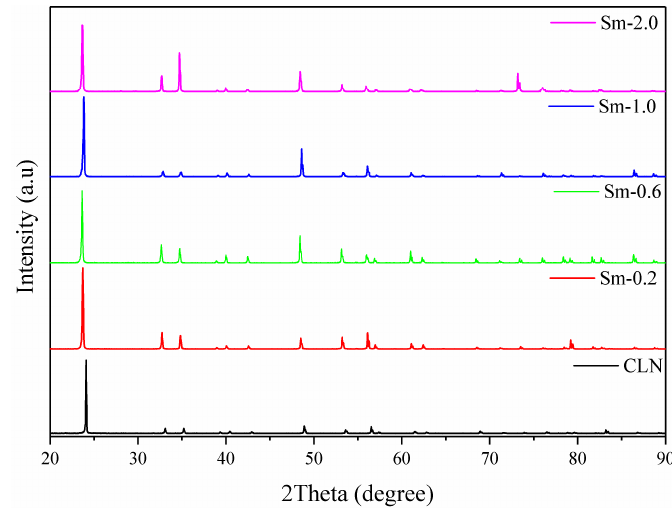
Figure 2. X-ray powder diffraction patterns of congruent LiNbO 3 and series Sm 3+ -doped LiNbO 3 single crystals.